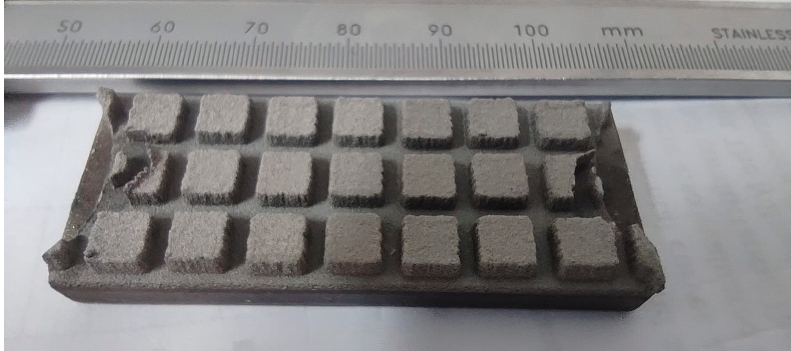
Figure 8. CSAM-ed Ti on stainless steel using masking strategy. Unit: mm.